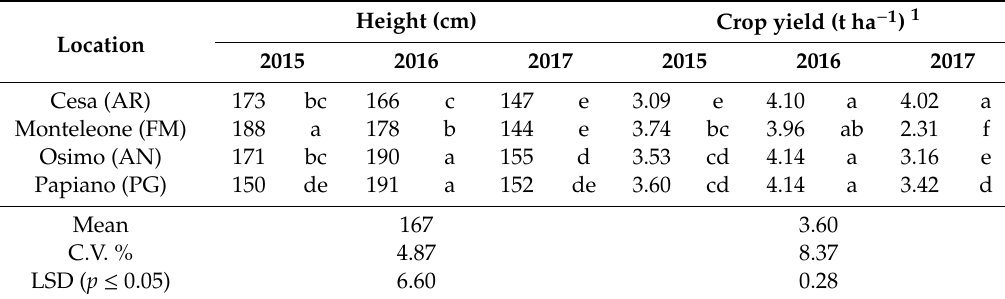
Table 1. Yield and plant height in di ff erent years and locations.